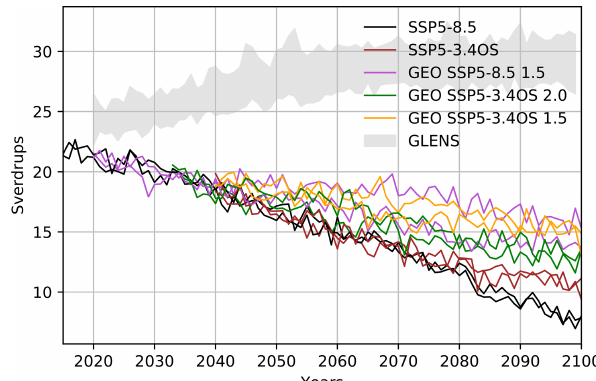
Figure 6. Evolution of the maximum North Atlantic Meridional Overturning Circulation strength from the AMOC index for the different scenarios and ensemble members. Shaded grey area is AMOC index range in the 21-member GLENS ensemble. The AMOC index is defined as the maximum flux in the Atlantic basin between 500m depth to the bottom, and between 28 and 90 ◦ N